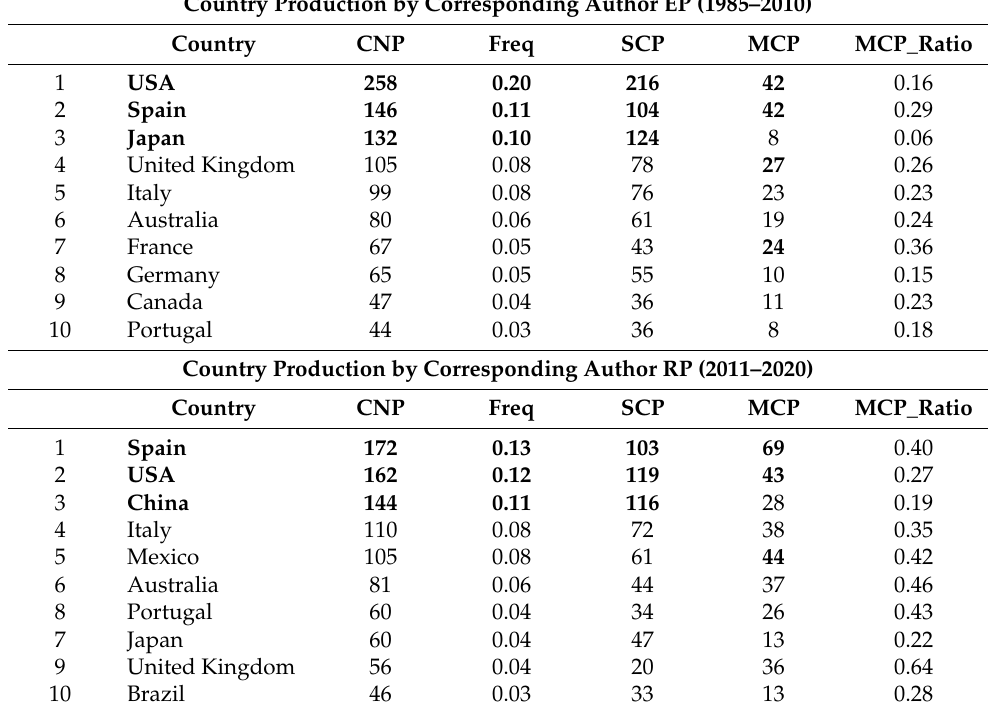
Table 4. Information about production of the first ten countries ordered by the total number of publications by corresponding authors (CNP) from 1985 to 2010 (“earlier period”: EP) and from 2011 to 2020 (“recent period”: RP). CFreq: citation frequency according to the publication by the corresponding author; SCP: single country publications (i.e., number of articles in which all authors belong to the same country); MCP: multiple countries publications (i.e., number of articles including at least a co-author working in a different country with respect to the corresponding author); TNP: the number of publications; TC: total citation received; The first three items are in